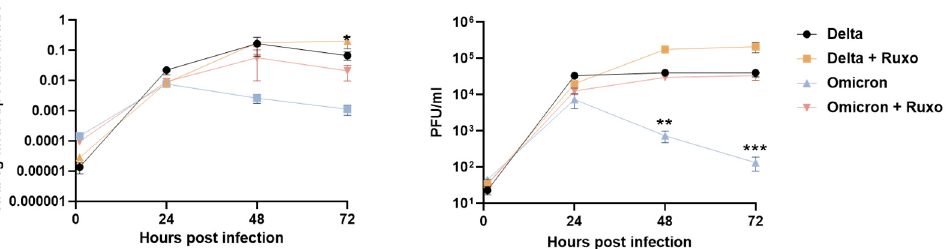
Figure 3. Ruxolitinib treatment restores Omicron replication in human lung tissues. Lung organ cultures were pretreated with 5 uM Ruxolitinib (Ruxo) 16 h when indicated. Treated and non-treated tissues were infected in parallel with Omicron and Delta (10 5 PFU/well). The levels of tissue-associated viral sub-genomic (sg)-mRNA (left panel) and infectious virus progeny released from the same infected tissue (right panel) represent mean values (±SEM) of four biological replicates. **, p < 0.01; ***, p < 0.001 .